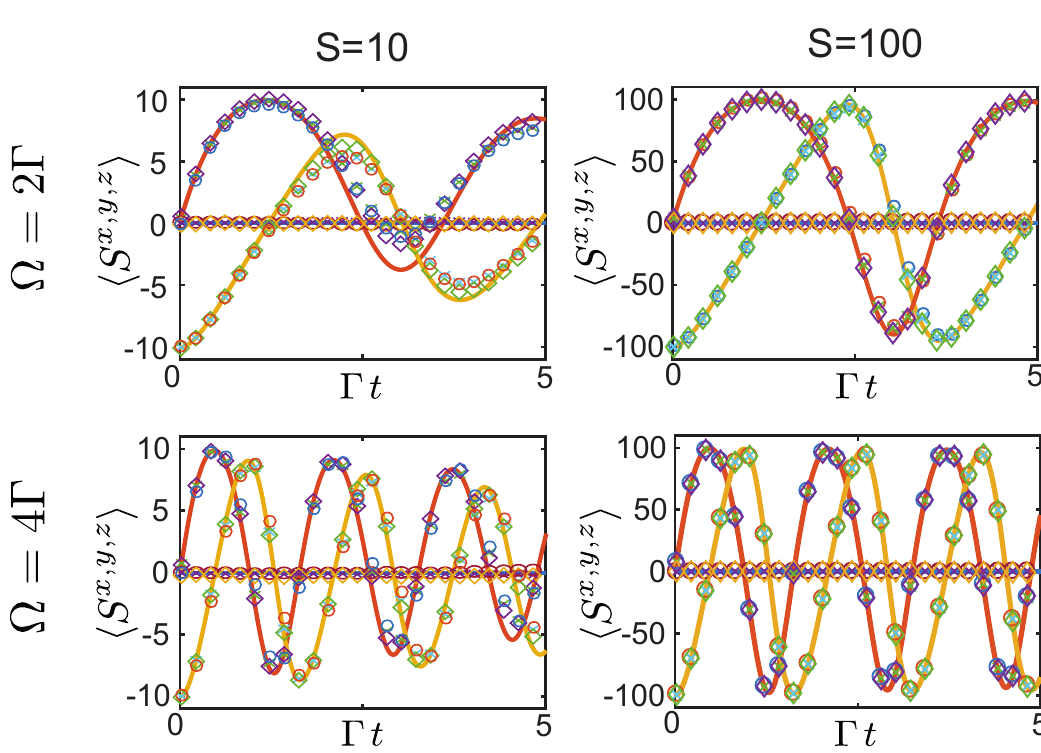
Figure 3: Time evolution of a driven collective spin in the presence of dissipation, as described by Eq. (29). The solid lines represent the exact dynamics of the spin expectation values 〈 S z 〉 (yellow line), 〈 S y 〉 (red line) and 〈 S x 〉 (blue line), while the crosses, diamonds and circles are obtained from the stochastic sampling of the P -, the Q - and the Wigner-distribution, respectively. For this simulation, the system is initialized in the fully polarized state | S z = − S 〉